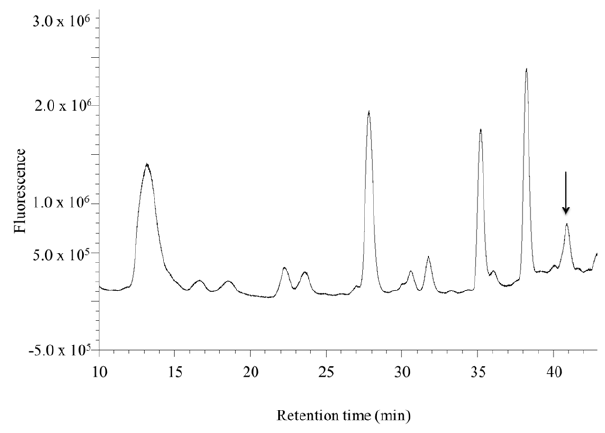
Figure 8. Detection of tagged JH III in mosquito samples by HPLC-FD. Extracts of hemolymph (diluted 1:10), CA-CC and whole body (diluted 1:20) from 24 h sugar-fed females were derivatized with DBD-COCl. The fluorescent peak with a retention time of 51 min represents JH III (arrows).